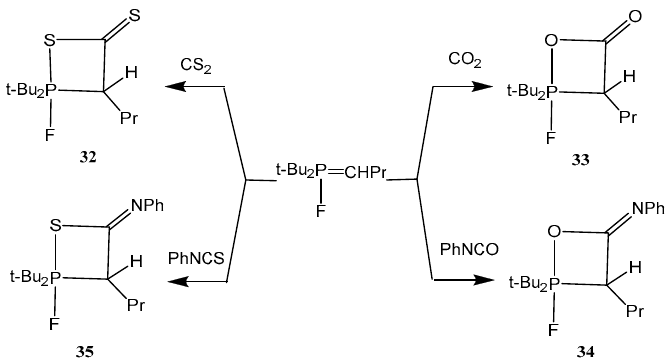
Scheme 20. Addition of heterocumulenes (X=C=Y) to P -fluoroylides.